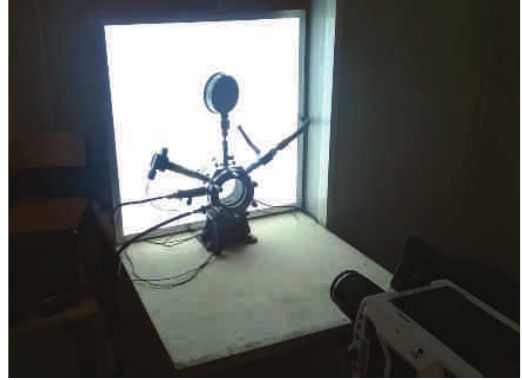
Fig. 1. Test bench with isochoric combustion chamber Schematic diagram of a constant-volume chamber with measurement systems: video footage, control of hydrogen supply and ignition system is presented in the Fig.